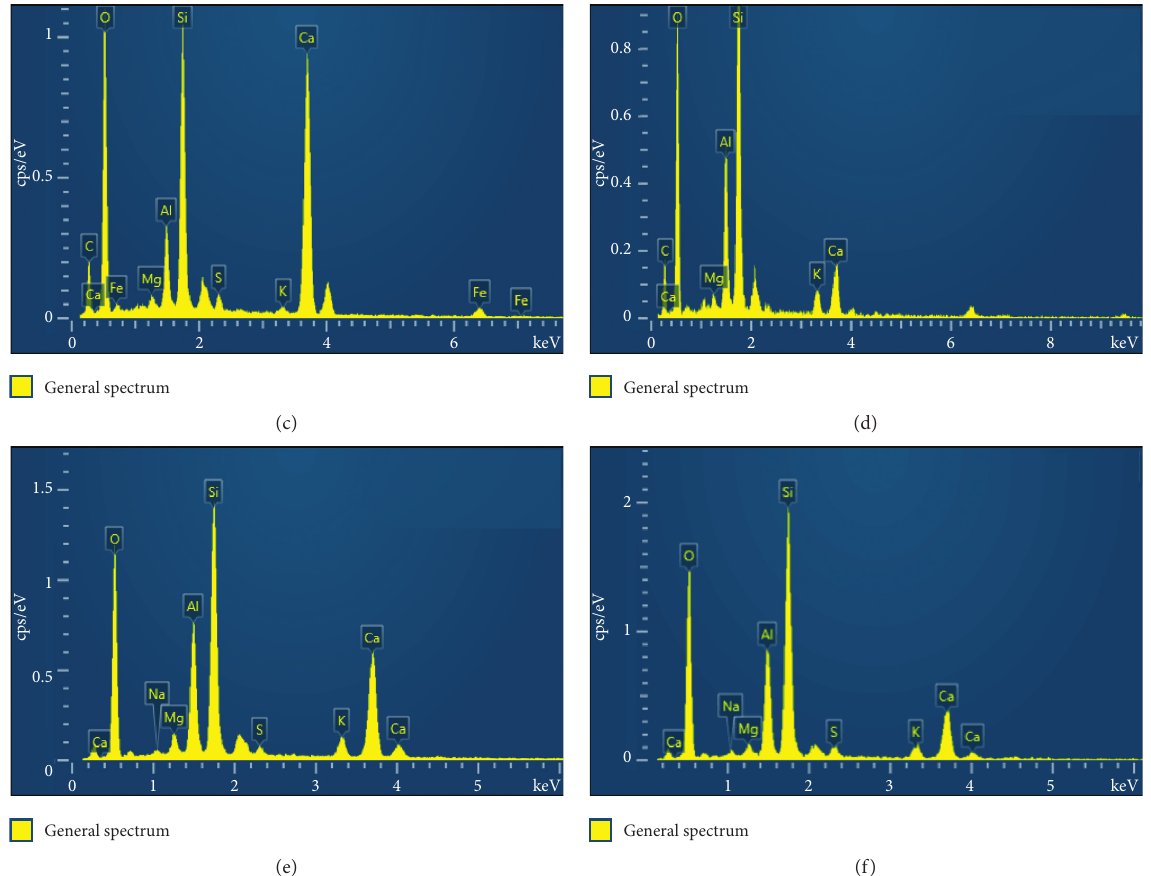
Figure 16: EDX test results under different cement content and curing age. (a) Cement content 5% and curing age 7 (d). (b) Cement content 5% and curing age 28(d). (c) Cement content 5% and curing age 90(d). (d) Cement content 20% and curing age 7 (d). (e) Cement content 20% and curing age 28(d). (f) Cement content 20% and curing age 90